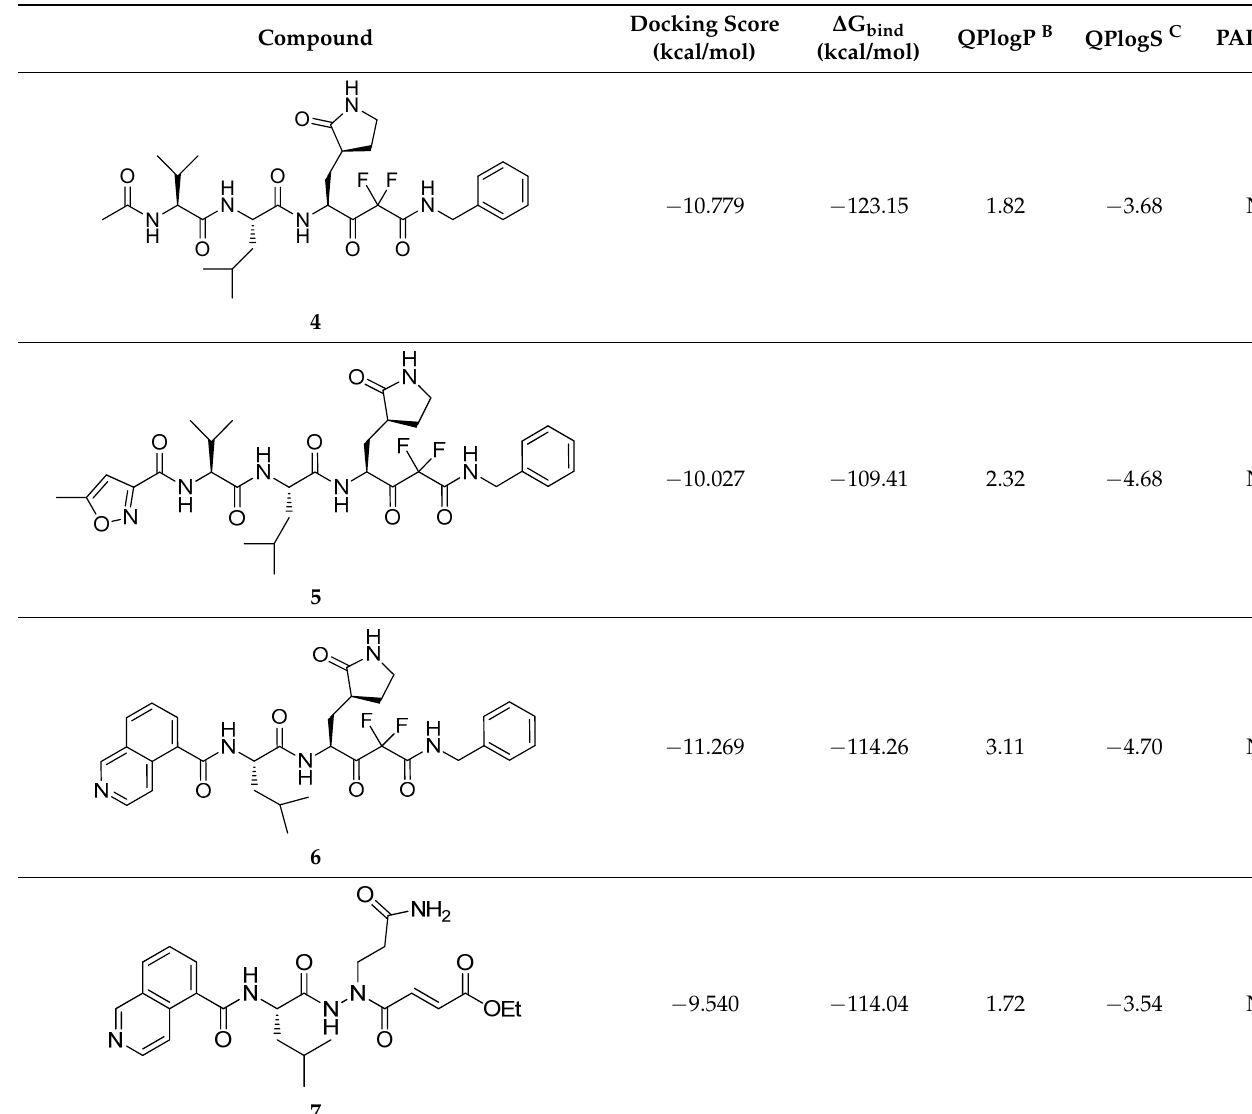
Table 1. Computational analysis regarding compounds 4 – 7 as potential M pro inhibitors, along with reference compounds 2 and 3 (N3).